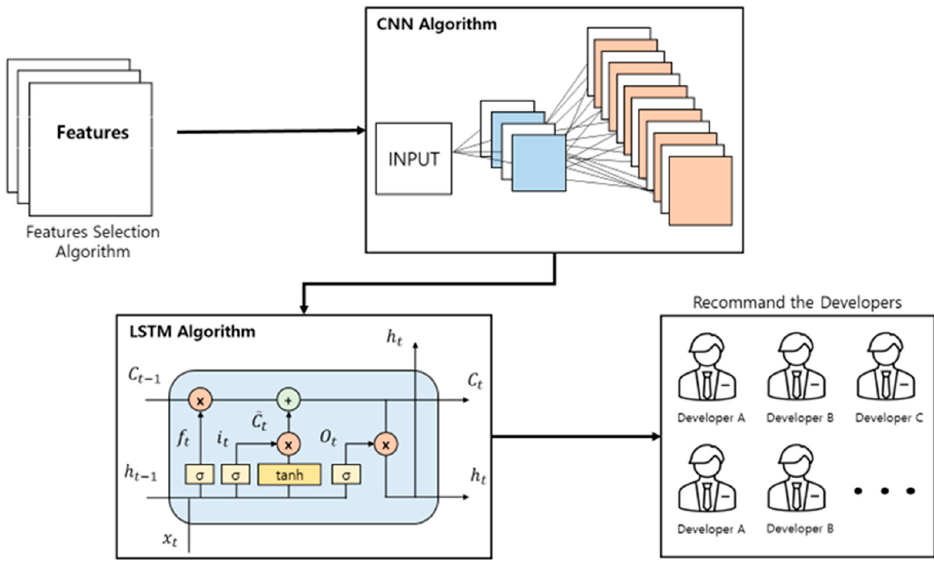
Figure 6. Overall schematic diagram of the CNN-LSTM algorithm.